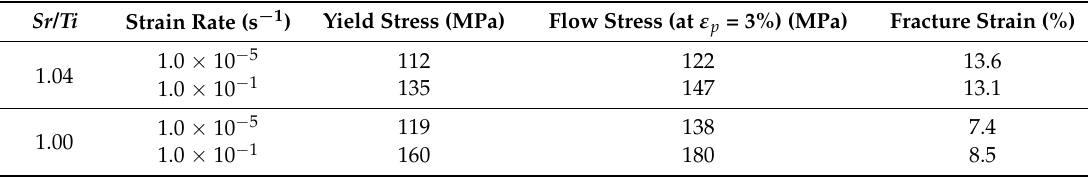
Table 1. Deformation stresses and fracture strains for SrTiO 3 single crystals.